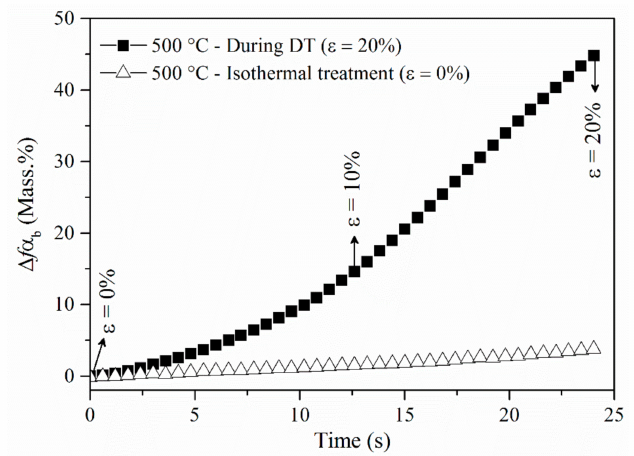
Figure 5. Changes in volume fraction of bainitic ferrite during DT ( γ → α b) at 500 ◦ C (squares) in contrast with a reference sample without deformation at 500 ◦ C (triangles). Note that volume fractions are displayed as “ ∆ ” from the starting point t = 0 s, which is counted after the intermediate holding step (see the inset of Figure 1a). Deformation stages (0, 10 and 20%) for DT are indicated in this